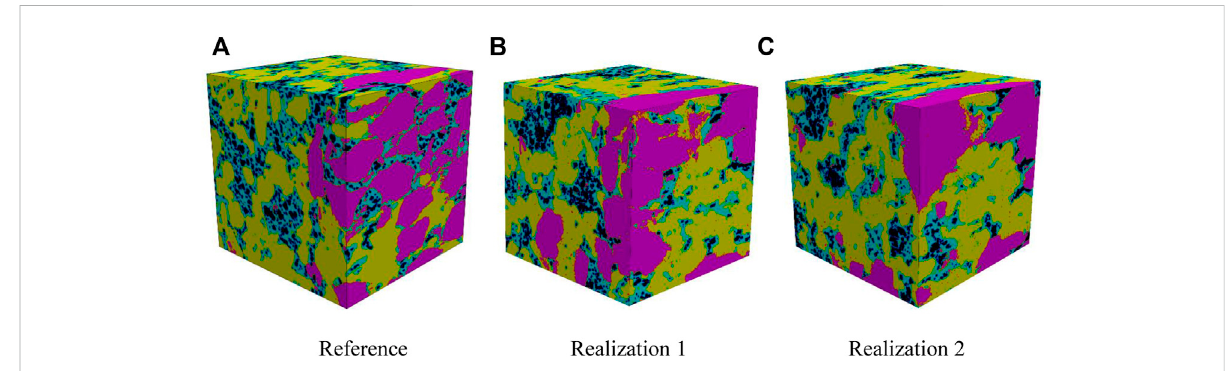
FIGURE 16 3D shale segmented digital rocks (A) Reference image, (B) and (C) are realizations one and two which are obtained by segmenting the reconstructedgrayimages.Blackrepresentstheorganicporephase,lightbluerepresentstheorganicphase,yellowrepresentsthematrixphase,and pink represents the pyrite phase.